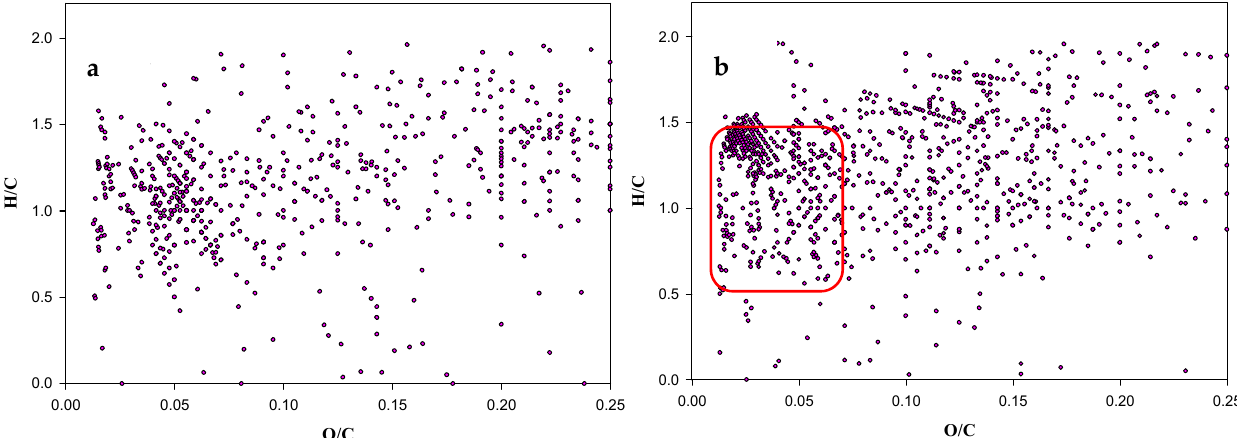
Figure 8. The van Krevelen plots of the O 1 –O 10 species found in the untreated crude oil WSF ( a ) and the 1-h photocatalysed sample ( b ).